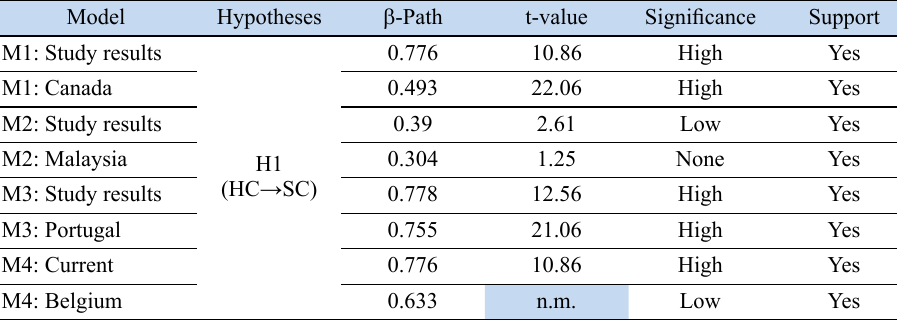
Table 4. Comparative summary results for Hypothesis